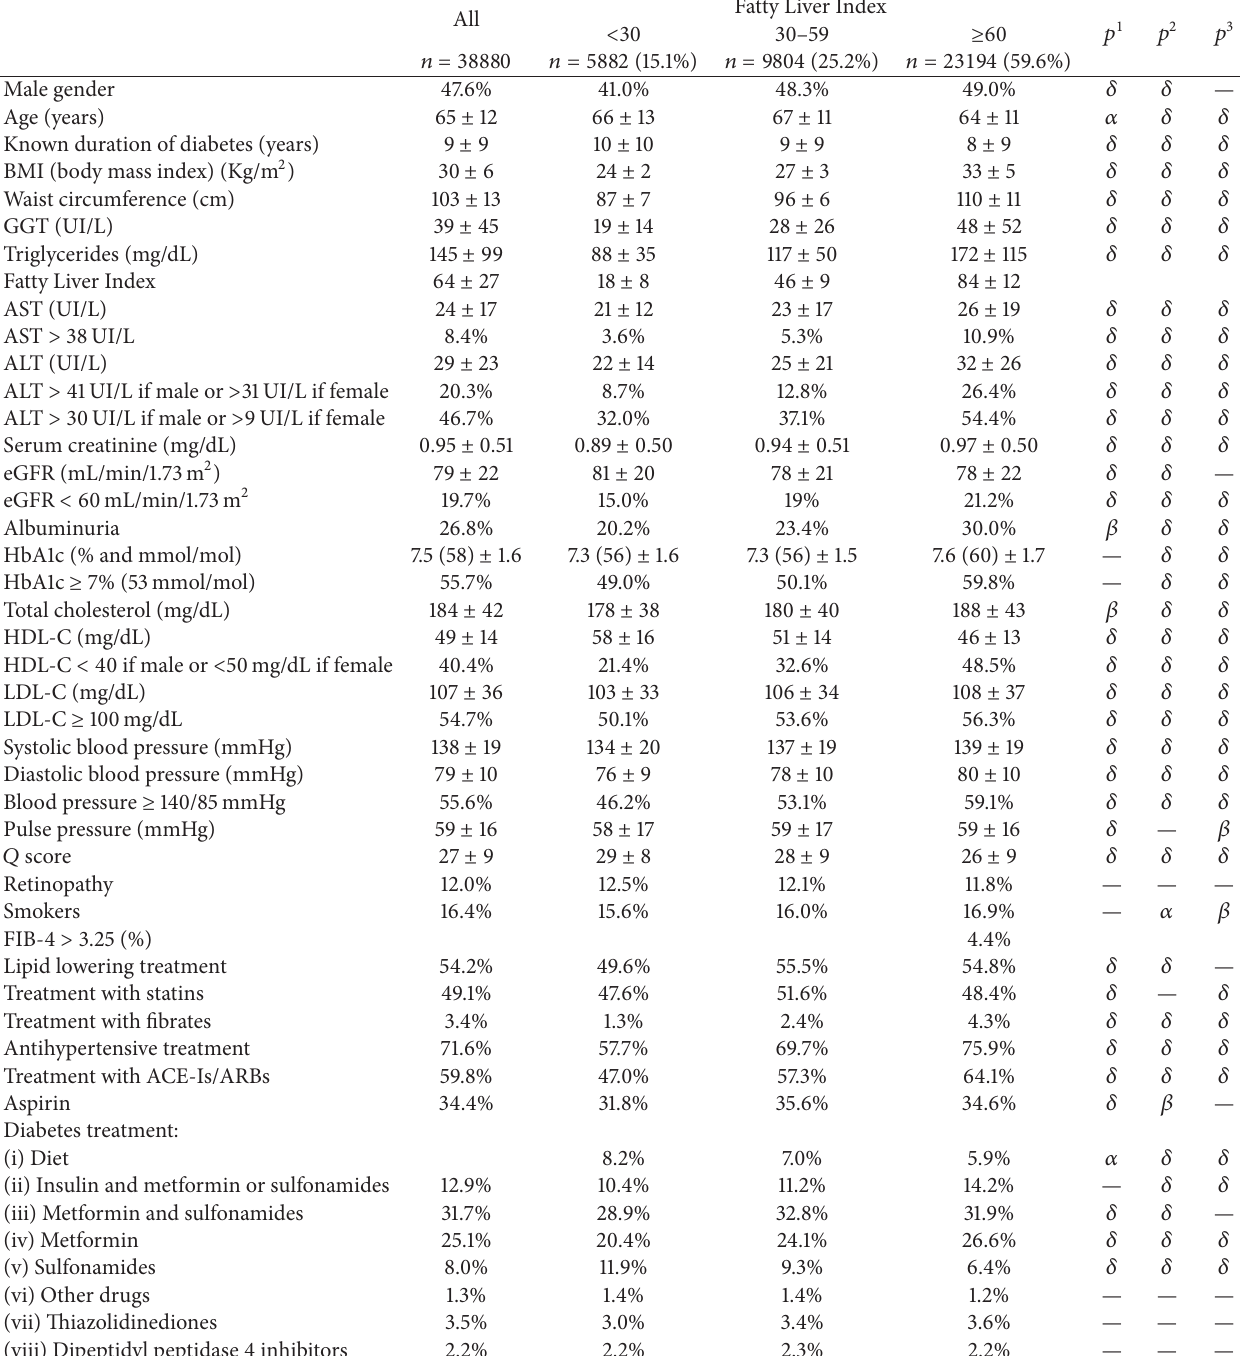
Table 1: Clinical features of patients according to Fatty Liver